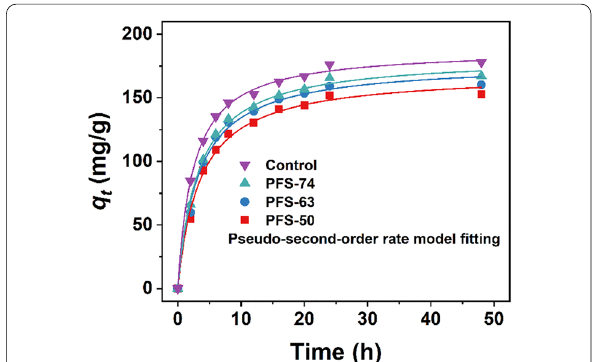
Fig. 3 Water absorption curve of PFSs retanned leathers and control leather (pseudo‑second‑order rate model fitting)